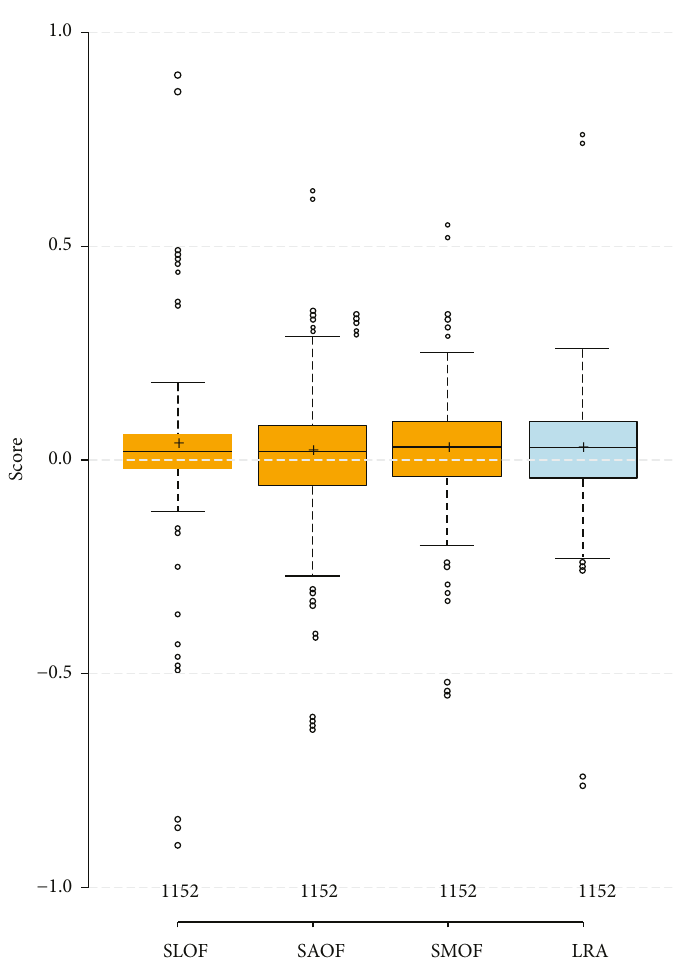
Figure 10: Boxplot of measurement scores for each algorithm. Boxplot uses values that are less than a 1.5x interquartile range from the 1st and/or 3rd quartile for the lower and upper whiskers (as de fi ned by Tukey [51]); box lower-bound is the 25th percentile, middle-bound is the median, and upper-bound is the 75th percentile, and “ + ” denotes an average (mean) value. Plotted using BoxPlotR [52]. Table 3: Summary of measurement scores as boxplot statistics. Boxplot